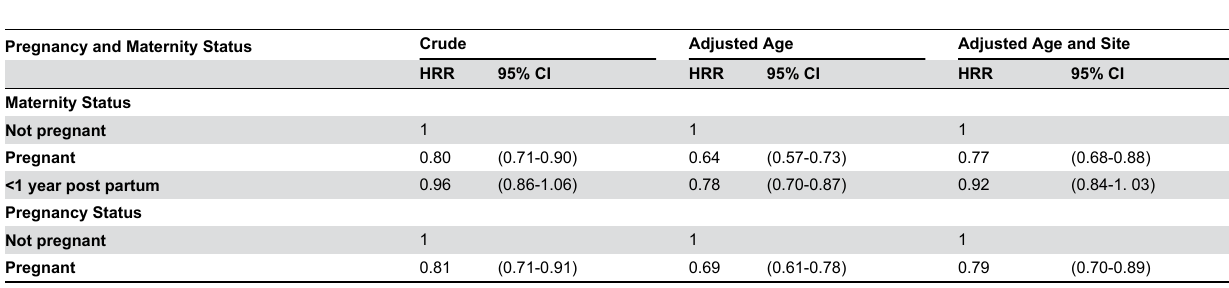
Pregnancy and Maternity Status